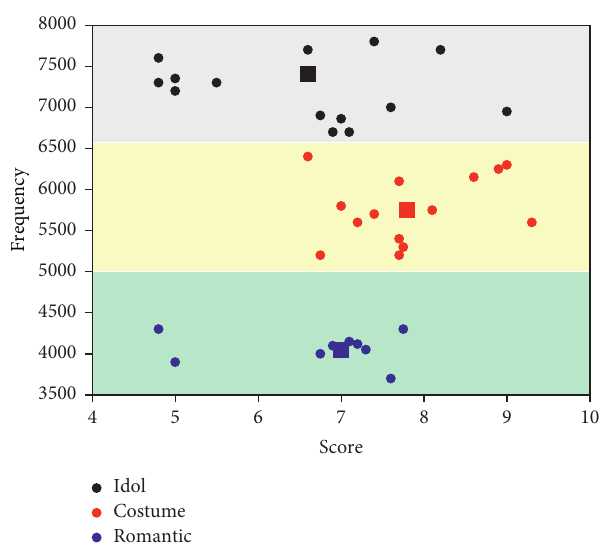
Figure 6: Clustering analysis results of TV